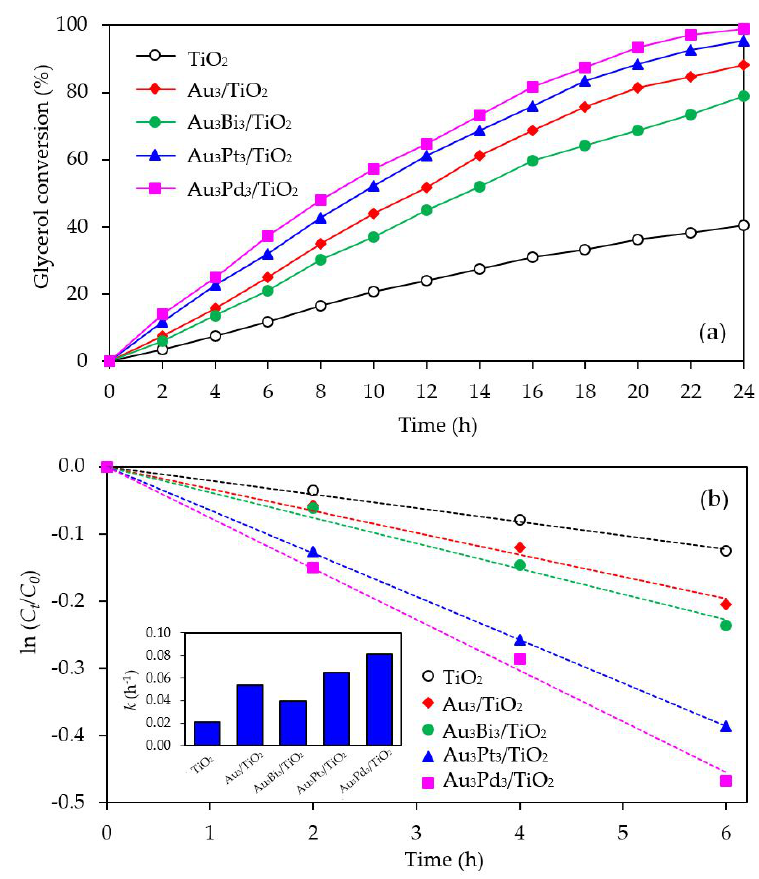
Figure 13. Representative ( a ) glycerol conversion and ( b ) a plot of ln ( C t / C 0 ) as a function of time in the presence of the respective Au 3 M 3 /TiO 2 photocatalyst at a loading of 3.0 g/L, light intensity of 4.7 mW/cm 2 and using O 2 as the electron acceptor.